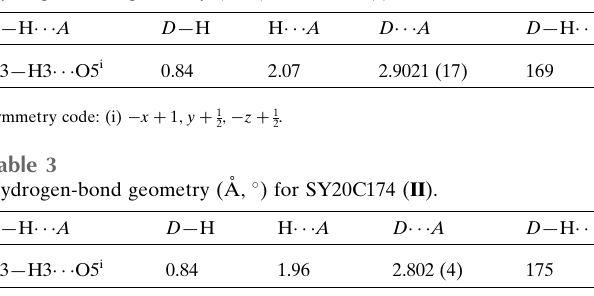
Table 2 Hydrogen-bond geometry (A˚ , (cid:4) ) for PL358 ( I ).